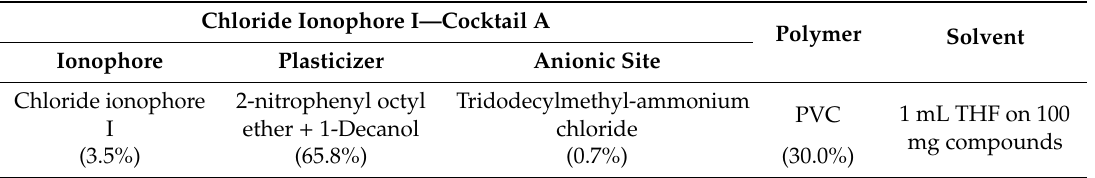
Table 1. Membrane compounds of the chloride-selective membrane using the chloride ionophore I –cocktail A with its corresponding portion in